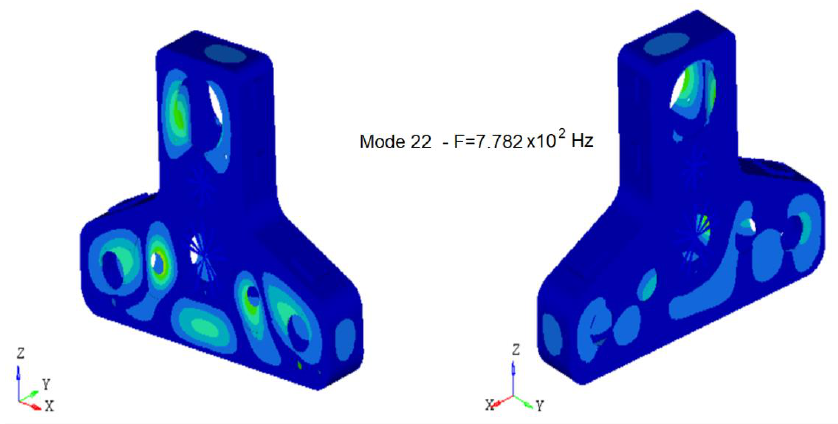
Figure 8. Eigenmode 22 (frequency — 78.28 Hz).